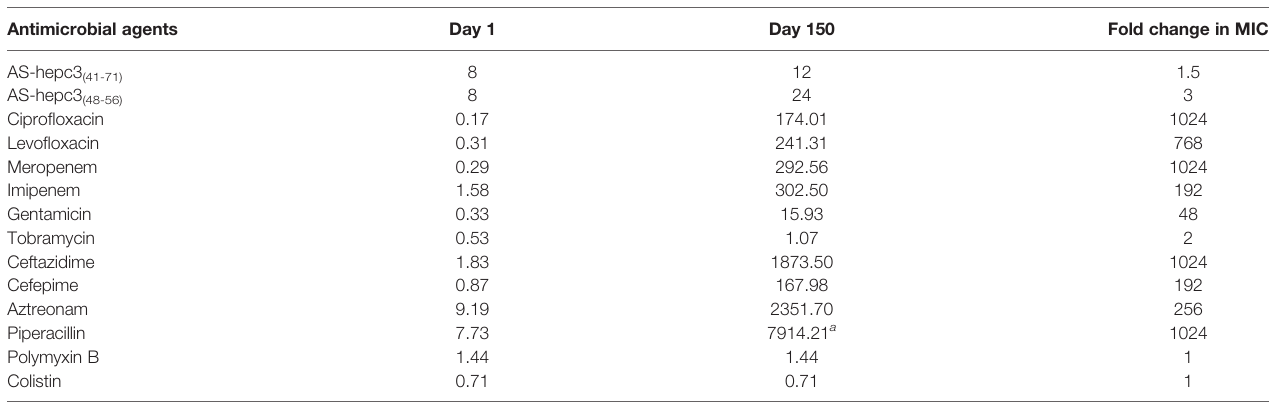
TABLE 4 | The MIC ( m M) values of antimicrobial agents against P. aeruginosa PAO1 on different days. Antimicrobial